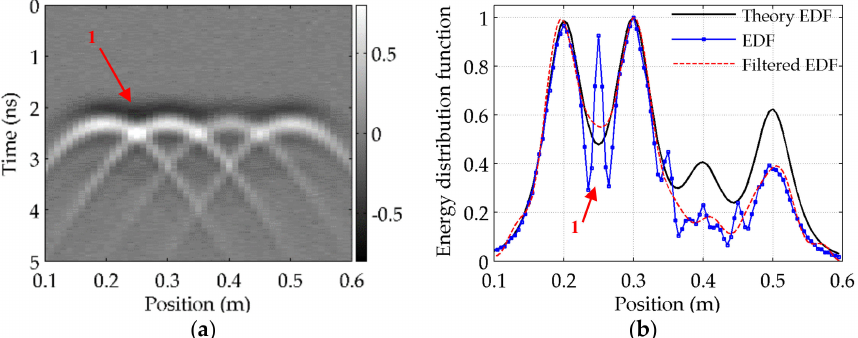
Figure 5. Numerical experimental data with multi scatters. ( a ) The radargram of the four preset targets biases 0.2 m, 0.3 m, 0.4 m and 0.5 m from the origin, with normalized backscattering intensities of 1.0, 1.0, 0.6 and 0.8 respectively. All depths are 0.05 m. Note that the direct wave is canceled with a pre-measured reference background signal. ( b ) shows the energy distribution function derived from ( a ), where the direct obtained and filtered energy distribution functions are illustrated with blue-dot and red-dash lines. For comparison, the black line presents the theoretical value. In ( a , b ), the red arrow indicates the strong interference of two echos, showing the cross modulation effect between targets.